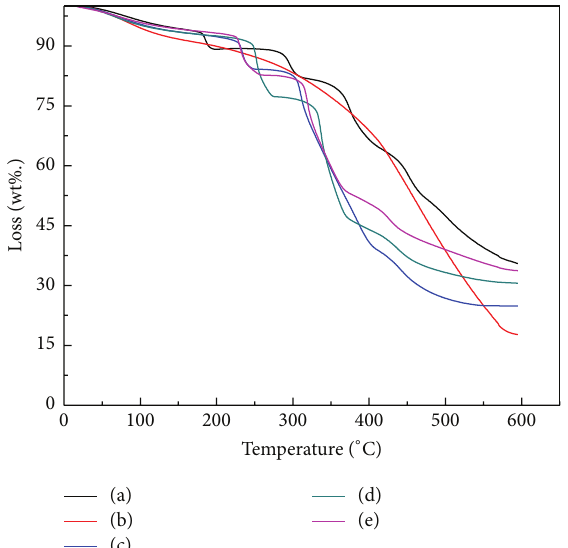
Figure 3: TGA curves of (a) 1wt% Ppy/TiO 2 , (b) 2 wt% Ppy/TiO 2 , (c) 3 wt% Ppy/TiO 2 , (d) 4 wt% Ppy/TiO 2 , and (e) 5 wt% Ppy/TiO 2